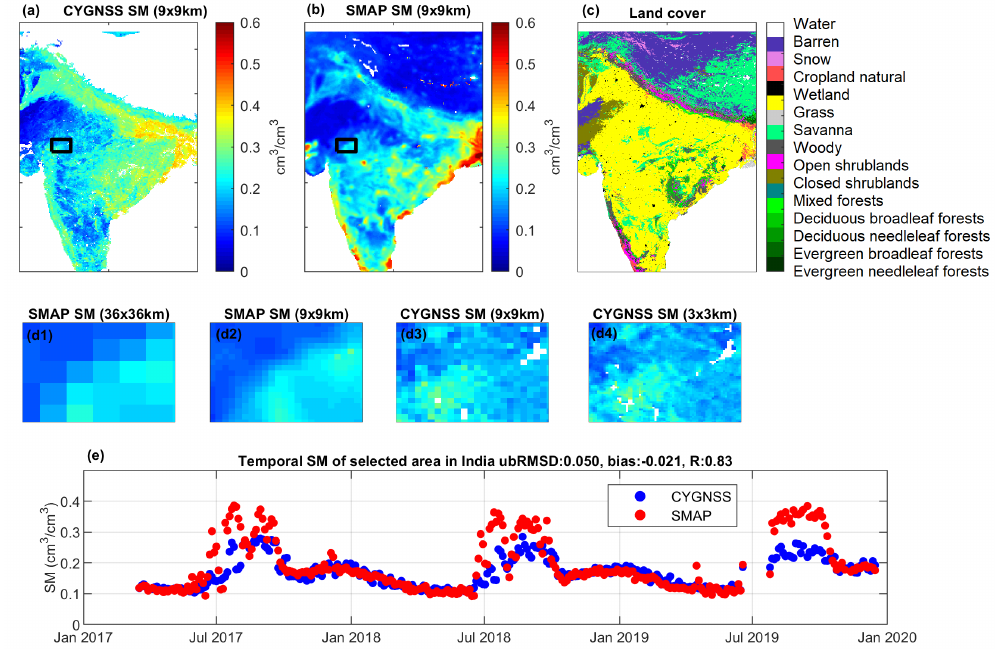
Figure 11. Averaged SM predictions for India during Oct 2018. ( a ) CYGNSS 9-km, ( b ) SMAP 9-km, ( c ) land cover map, ( d ) detailed images of selected area for SMAP 9-km and 36-km and CYGNSS 3-km and 9-km, and ( e ) a time-series example from selected